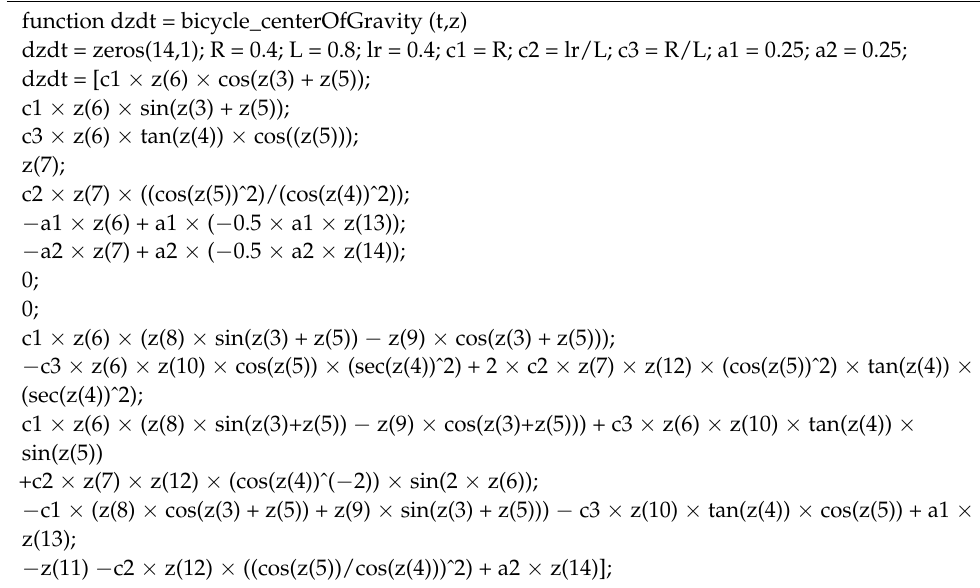
Algorithm 3 State–costate system of ordinary differential